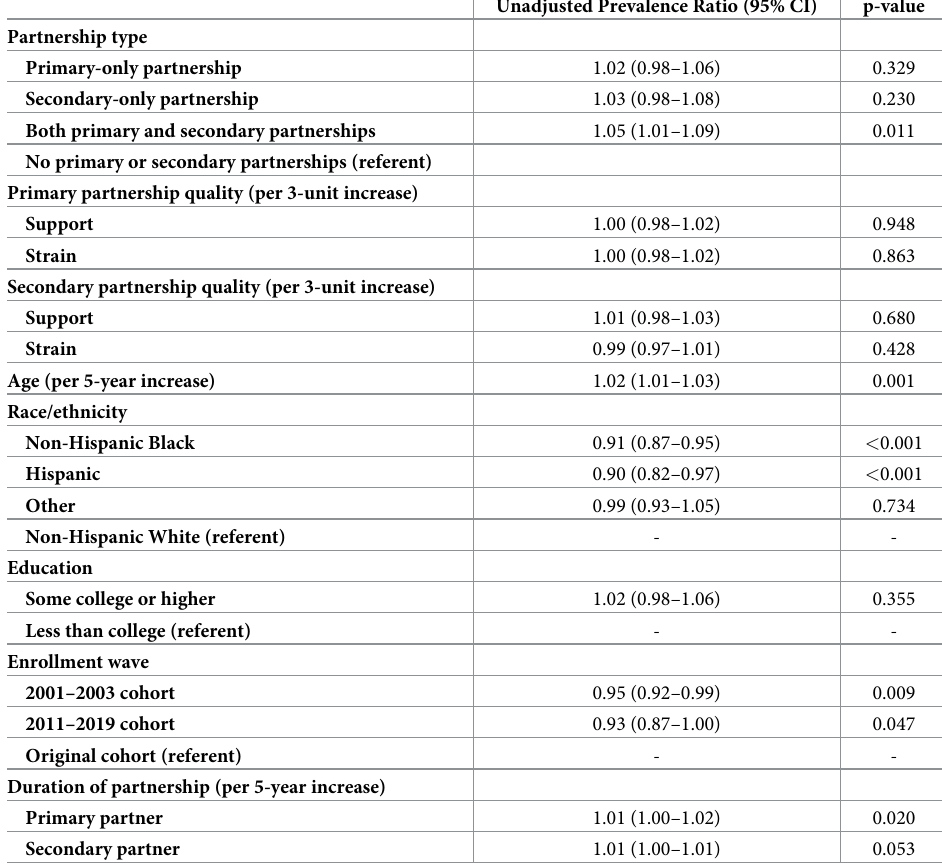
Table 2. Unadjusted association of partnership type, primary partnership quality, secondary partnership quality, covariates, and viral load suppression.